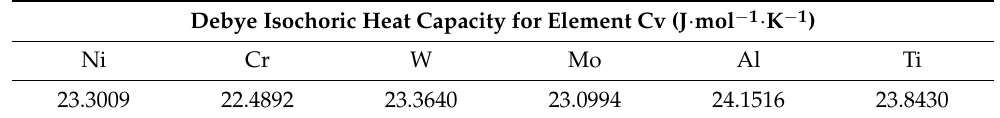
Table 5. Debye isochoric heat capacity for element.